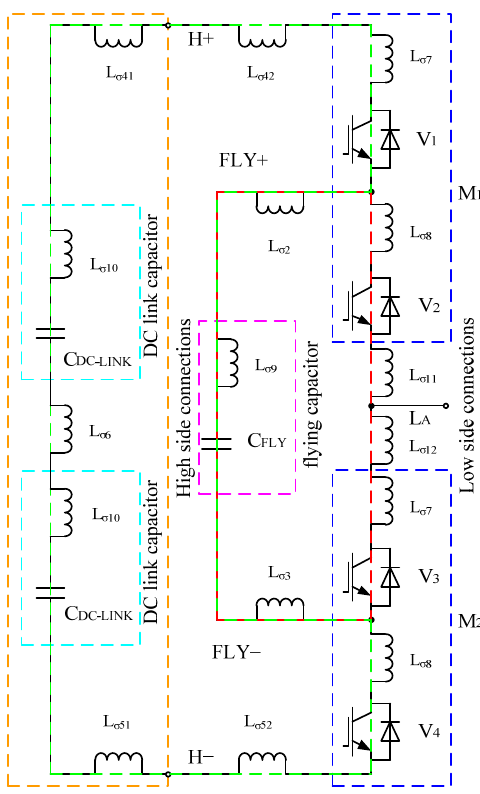
Figure 10. A lumped stray inductance model of inner and outer commutation paths for the PEBB of FC ‐ 3L ‐ BDC.